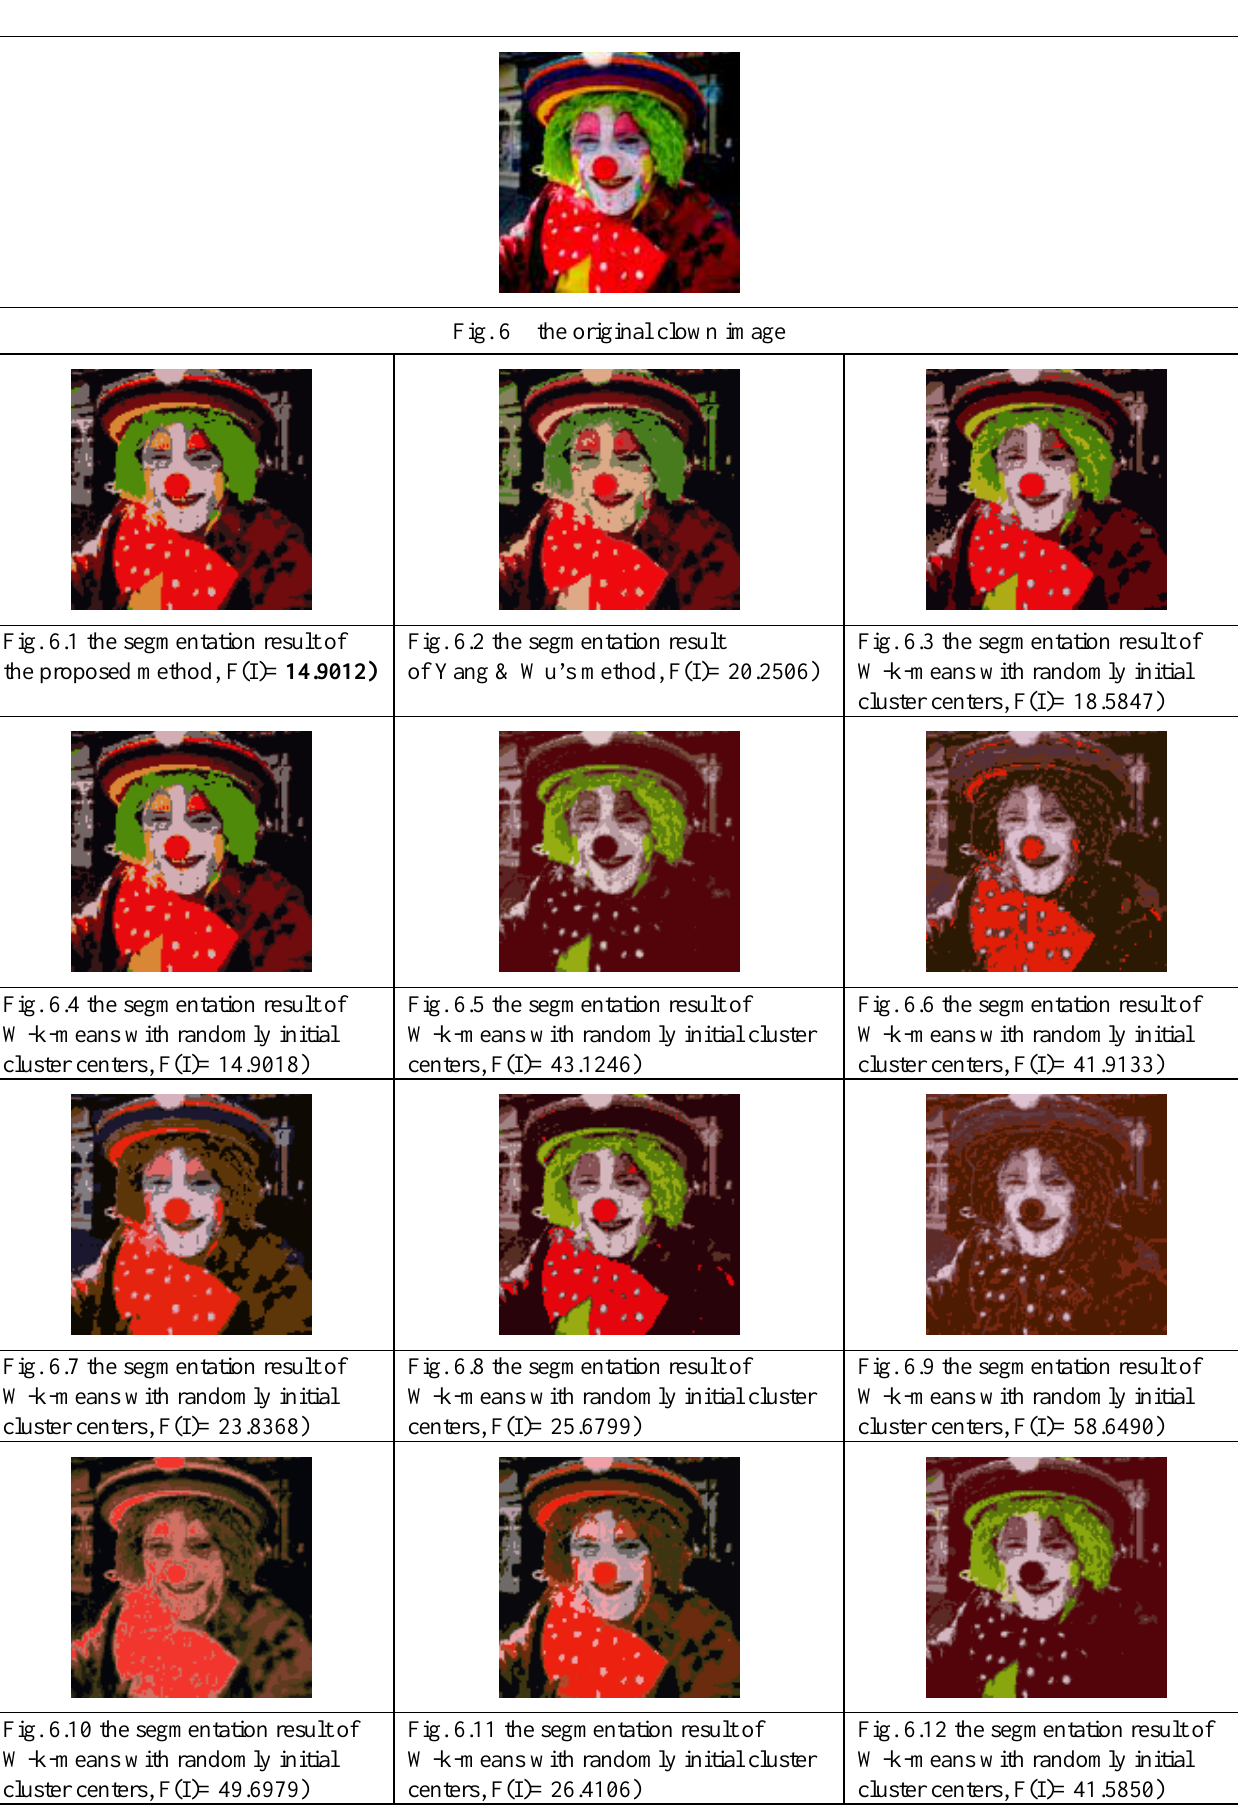
Fig. 6.11 the segmentation result of W-k-means with randomly initial cluster centers, F(I)= 26.4106)